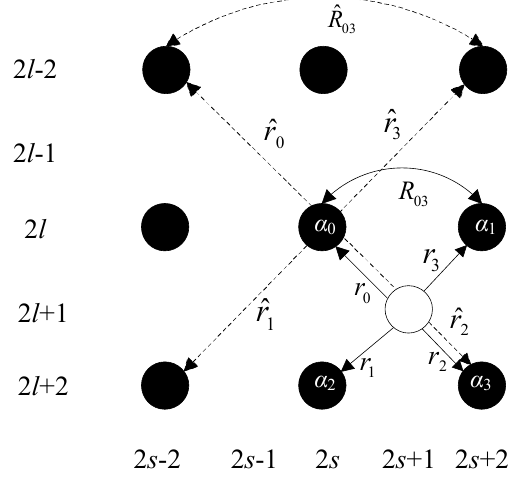
Figure 5. The first stage of interpolation.